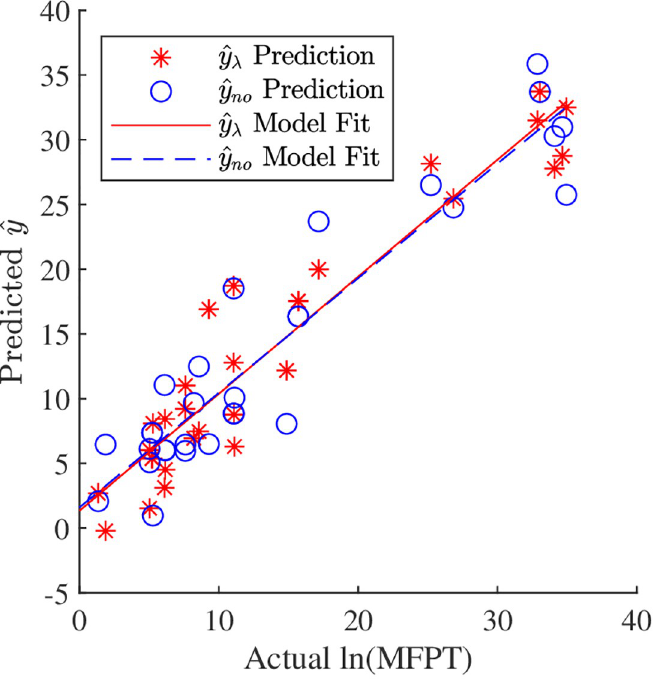
Fig 3. Fall risk model prediction ( ^ y ) compared to the true MFPT for the Markov chain data used to create the model. The two lines on the plot are a linear fit of the data (Eq 15). In general, as the actual MFPT increased, the prediction from both models